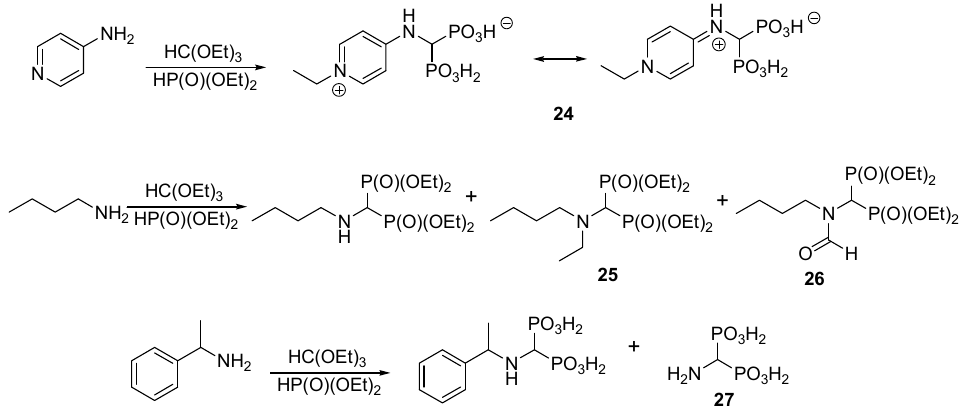
Scheme 15. Representative side products of the three-component procedure for the synthesis of aminomethylenebisphosphonic acids.